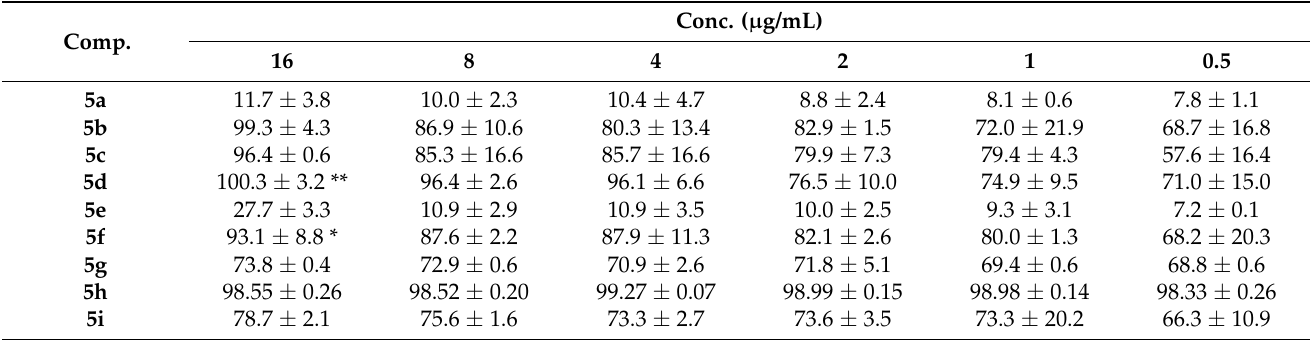
Table 2. Antifungal activity of benzoxazole derivatives against C. albicans ATCC SC5314.